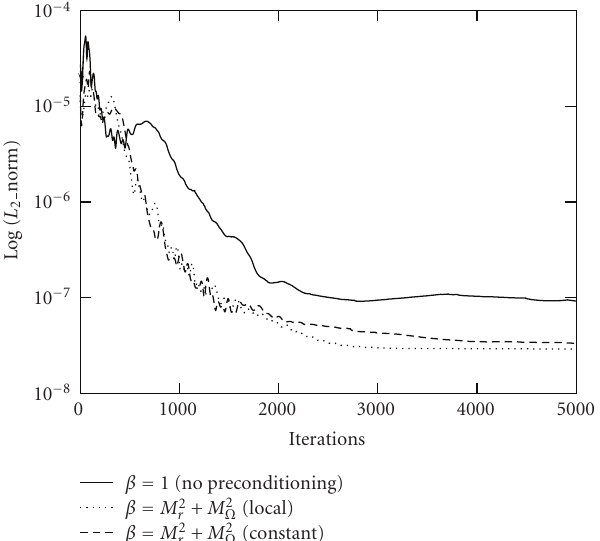
Figure 11: Comparison of predicted and measured propeller thrust and torque.